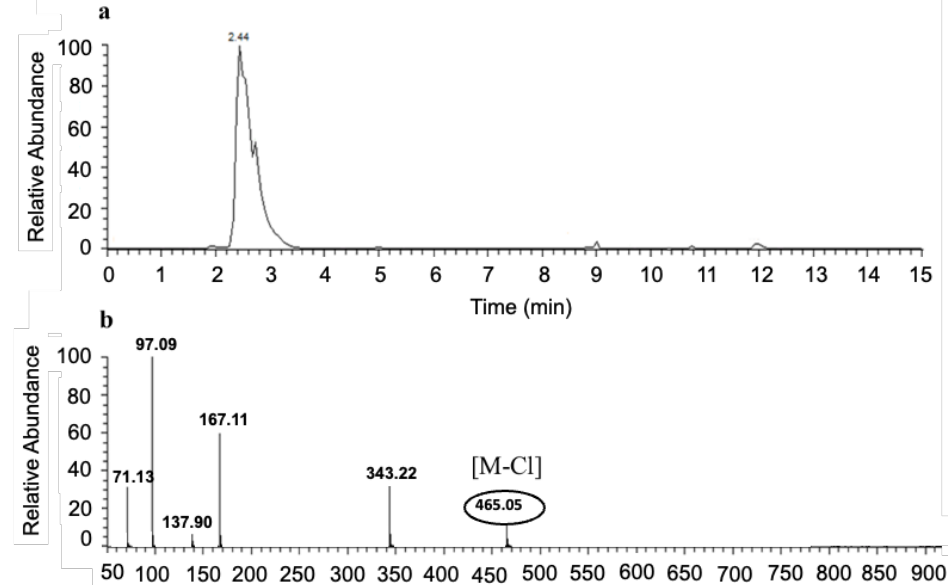
Figure 6. SRM LC-MS of NRTBCl. ( a ) SRM LC of NRTBCl. ( b ) Mass spectrum of NRTBCl.